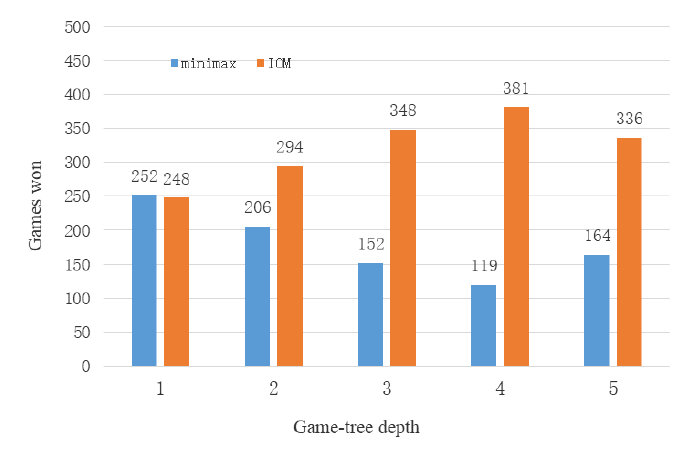
Figure 8. The experimental results for IOM vs. minimax in gobang.